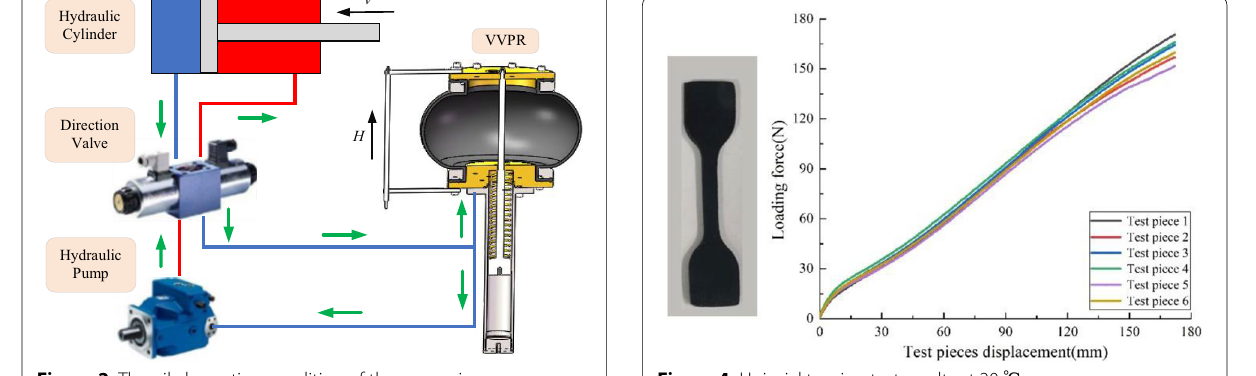
Figure 2 The oil absorption condition of the reservoir